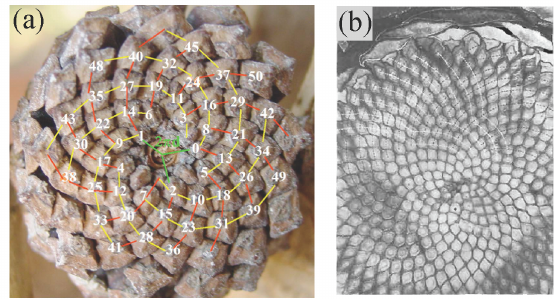
Fig. 4: (a) A pinecone with the bracts numbered in order of their distance to the center. Also marked are eight counterclockwise spirals (in yellow) and thirteen clockwise spirals (in red) formed by con- necting adjacent bracts. (b) From [3], a sunflower seed head with clockwise and counterclockwise spirals marked. The spiral families are different near the outer boundary of the seed head compared to the